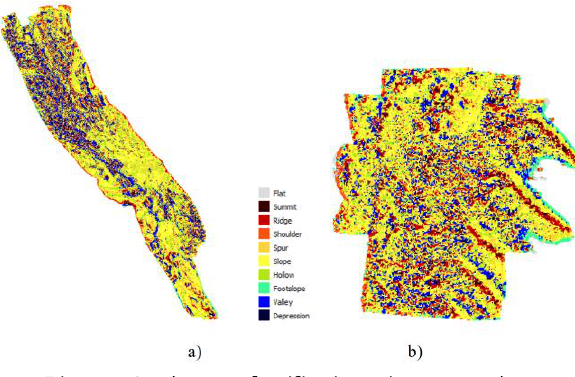
Figure 1. Sea-bottom classification using geomorphon approach: a) steep slope river bed with boulders; b) field